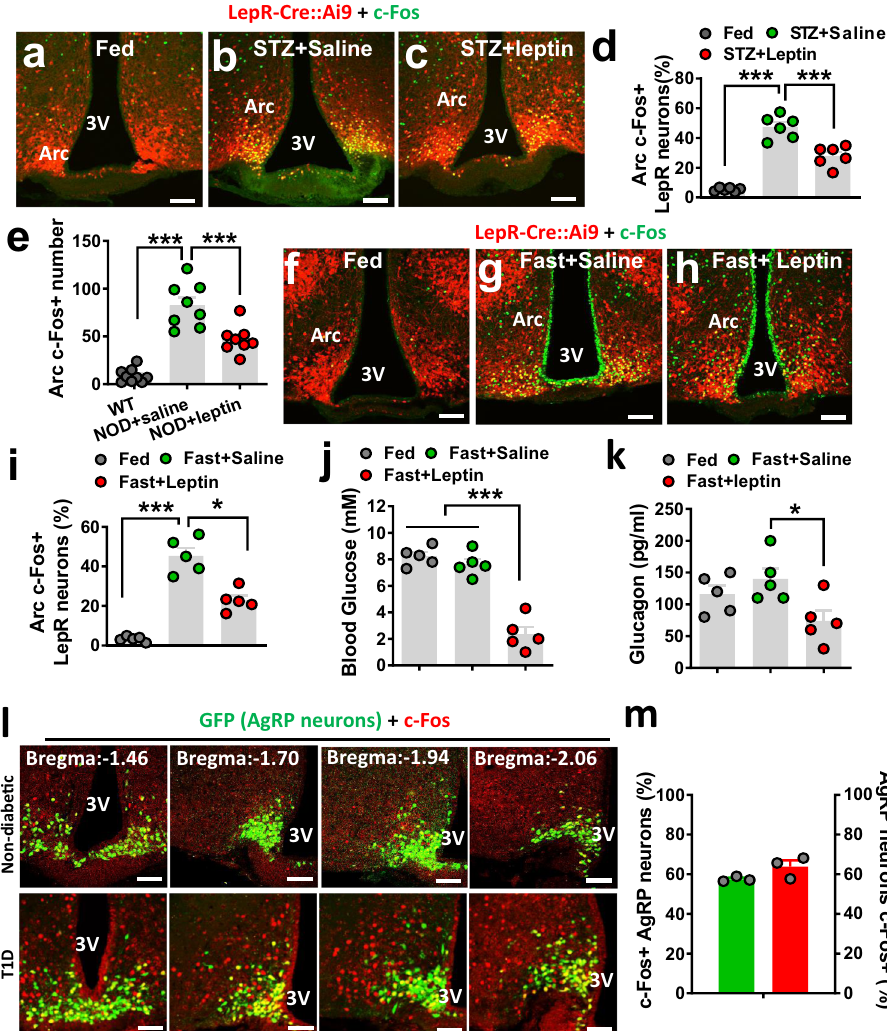
Fig. 1 Leptin suppresses counter-regulatory responses to fasting. a – i Leptin-Cre:Ai9 mice (8 – 10 weeks of age, males) were used as fed controls ( a , f ), made type 1 diabetic induced by STZ administration ( b , c ), subject to overnight fasting ( g , h ), or treated with i.c.v. leptin infusion ( c , h ). LepR neurons were shown by Ai9 reporter expression (red) and immunostaining was performed for c-Fos (green) ( a – c , f – h ). d – i Comparison in the percentage of LepR neurons with c-Fos expression among the indicated groups was shown in T1D mice ( d , one-way ANOVA, n = 6/each, F (2, 10) = 136.9, *** P <0001, control vs STZ-saline; *** P = 0.004, STZ-saline vs STZ-leptin) or controls ( i , one-way ANOVA, n = 5/each, F (2, 8) = 44.4, *** P <0.0001, fed vs fast-saline; * P = 0.0035, fast-saline vs fast- leptin). e Comparison in the numb e r of c-Fos neurons in the Arc in controls, saline, and leptin-treated nonobesity diabetic (NOD) mice (one-way ANOVA, n = 9 for WT and n = 8 for both NOD-saline and NOD-leptin, F (2, 22) = 44.69, *** P <0.0001, WT vs NOD-saline; *** P = 0.0006, NOD-saline vs NOD-leptin). j , k In mice presented in panels f – i , comparisons were shown in glucose levels between fed and fasting, and between saline and leptin treatment conditions ( j , one- way ANOVA, n = 5/each, F (2, 8) = 116.6, *** P <0.0001, fed vs fast-leptin; *** P <0.0001, fast-saline vs fast-leptin) and in glucagon levels between saline and leptin-treated groups ( k , one-way ANOVA, n = 5/each, F (2, 8) = 4.575, P = 0.1745, fed vs fast-leptin; * P <0.0427, fast-saline vs fast-leptin). Blood glucose was measured between fed and 8-h fast (from early morning to late afternoon) and blood glucagon was measured at 8-h fasting. l , m In AgRP-Cre GFP-reporter mice, colocalization of c-Fos induction in STZ-T1D was shown in GFP-positive neurons in a series of sections from rostral to caudal Bregma levels ( l ) and percentage of c-Fos neurons that were colocalized in AgRP and percentage of AgRP neurons were c-Fos positive in T1D mice ( m , n = 3/each). 3V the third ventricle, Arc arcuate nucleus, scale bar: 100 µ M. All data presented as